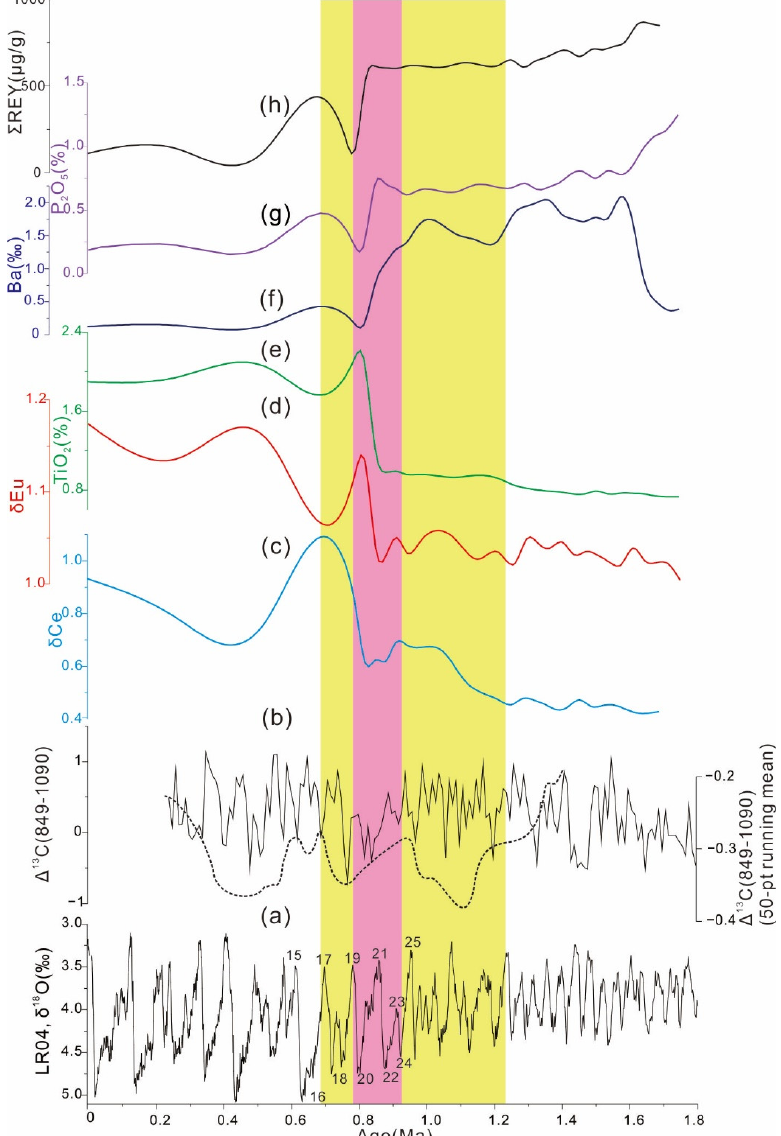
Figure 9. Comparison of selected climatic and environmental proxies of sediments from core PC15. ( a ) LR04 marine foraminifer oxygen isotope stack [5]. Marine isotopic stages (15–25) are labeled. ( b ) Inter-basinal carbon isotope gradient (solid line) between Pacific Site 849 and South Atlantic Site 1090 [44], with a 50-point running average (dash line). ( c – h ) δ Ce, δ Eu, contents of TiO 2 (%), Ba (‰), P 2 O 5 (%) and REY ( μ g/g) of core PC15. The Mid-Pleistocene Transition is highlighted by yellow shades and labeled, the 900 ka interval is highlighted by pink shades.